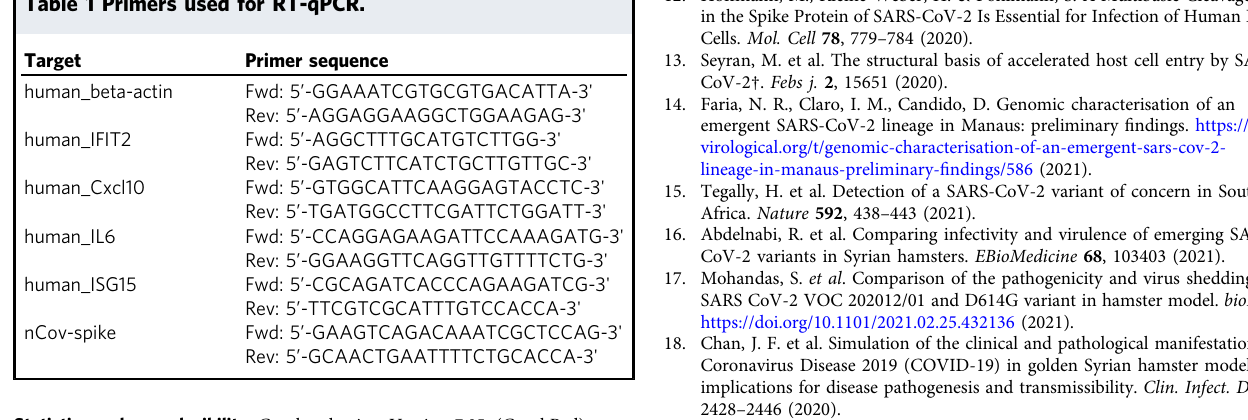
Table 1 Primers used for